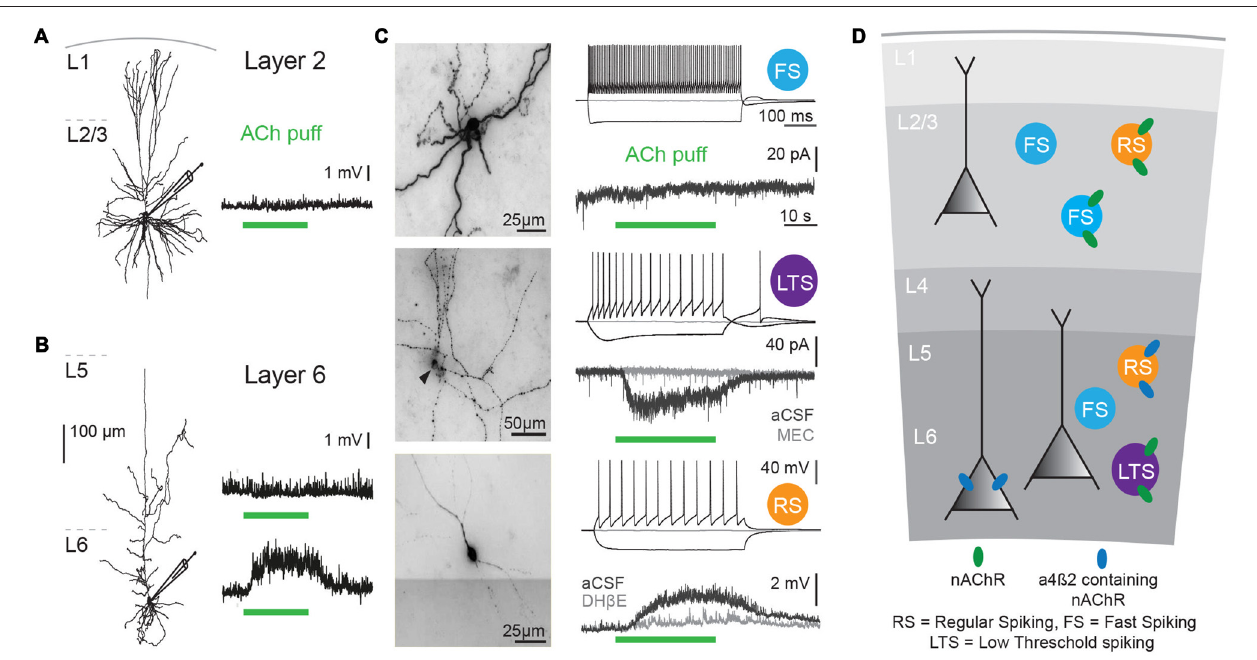
FIGURE 1 | Cholinergic responses in adult human neocortex are cell type and lamina-dependent. (A) Left: example reconstruction of biocytin-labeled human L2/3 pyramidal neuron. Right: No change in membrane potential occurred in response to a local application (puff) of 1 mM Acetylcholine (Ach; green bar, 30 s). (B) Left: example reconstruction of biocytin-labeled human L6 pyramidal neuron. Right: examples of no change in membrane potential (top) and a depolarization (bottom) in response to a local application of 1 mM ACh (green bar, 30 s). (C) Examples of biocytin-labeled human interneurons, with action potential firing profiles in response to step current injections and voltage or current responses to local application of 1 mM ACh (green bar, 30 s). Gray traces were recorded in the presence of nicotinic acetylcholine receptor (nAChR) blockers mecamylamine (MEC, middle traces, 1 µ M) or dihydro-b-erythroidine hydrobromide (DH β E, bottom traces, 1 µ M). (D) Overview of functional nicotinic AChR expression in pyramidal neurons and the predicted expression in interneurons in different lamina of the human temporal cortex. Data figures are representing edited versions of previously published findings (Alkondon et al., 2000; Verhoog et al.,